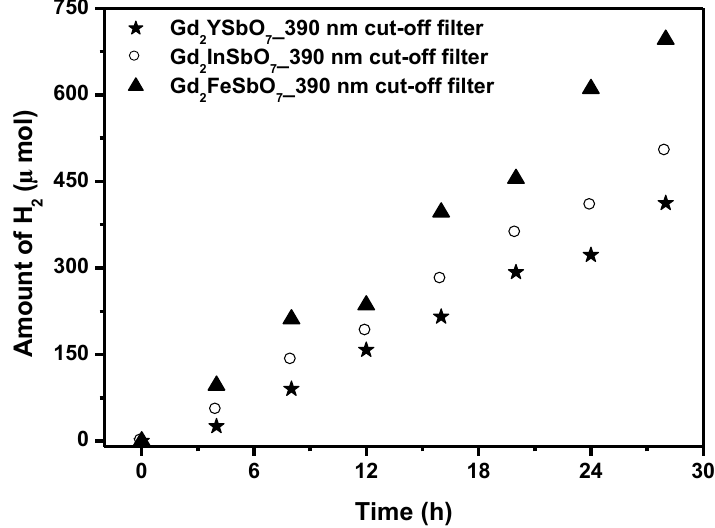
Figure 5. Photocatalytic H 2 evolution from aqueous methanol solution with Gd 2 FeSbO 7 , Gd 2 InSbO 7 or Gd 2 YSbO 7 as catalyst under light irradiation (390 nm cut-off filter, 0.5 g 0.1 wt% Pt-loaded powder sample, 50 mL CH 3 OH, 200 mL pure water). Light source: 300 W Xe